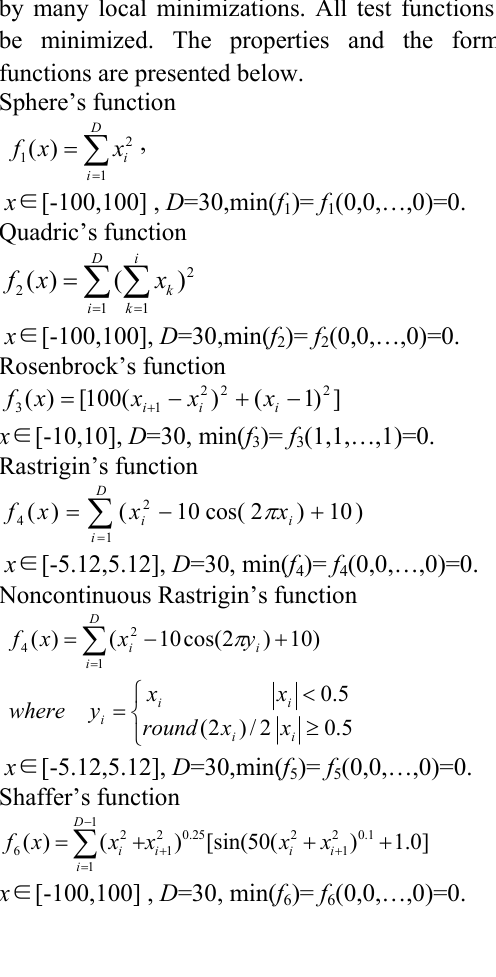
Table 2 Results of different PSO